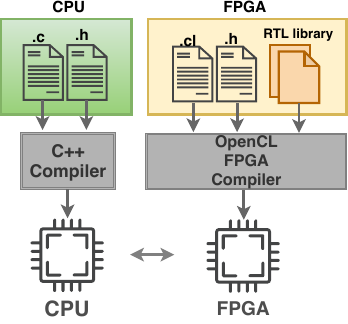
Figure 3. OpenCL high-level synthesis for Field Programmable Gate Arrays